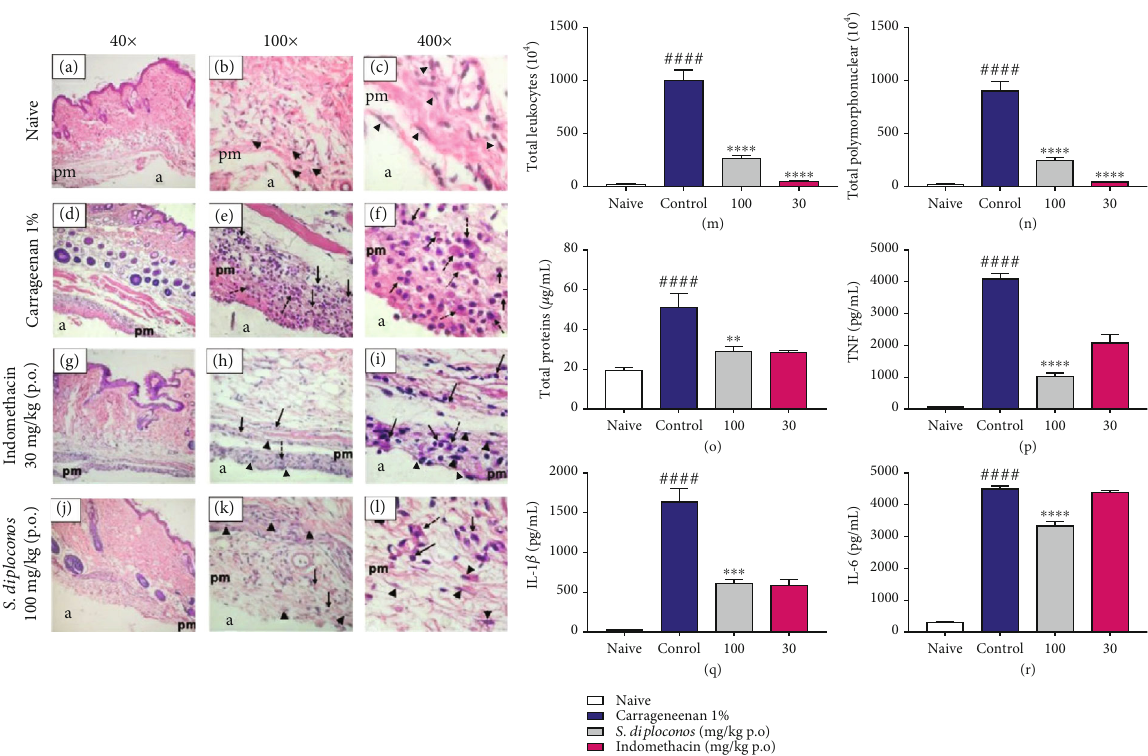
Figure 4: S. diploconos actions in mouse air pouches challenged with carrageenan. Air pouch was induced in the dorsal subcutaneous tissue of Swiss mice. The animals were treated orally one hour before the injection of 2mL of carrageenan (1%). Representative H.E. histological sections of skin biopsies obtained from mice with air pouches (40, 100, and 400x). Black arrows indicate PMN leukocytes, dashed black arrows indicate macrophages, and arrowheads indicate fi broblasts (a-l). Air space pouch “ a ” ; pouch membrane “ pm. ” The lavage of the in fl ammatory in fi ltrate was collected 4 hours after the injection of carrageenan into the air pouch. The determination of the (m) total number of exudate cells was performed on a Neubauer chamber, and the (n) di ff erential value was performed. (o) The protein concentration was measured in a spectrophotometer at 590 nm using the Bradford reagent. The levels of (P) TNF α , (q) IL-1 β , and (r) IL-6 were determined by the ELISA method. Values express the mean ± SEM of tests performed with the in fl ammatory exudate obtained from 6 animals per group. ∗ p < 0 : 05 , ∗∗ p < 0 : 01 , and ∗∗∗∗ p < 0 : 0001 , vs. the control group signi fi cantly di ff erent from the naïve group ####